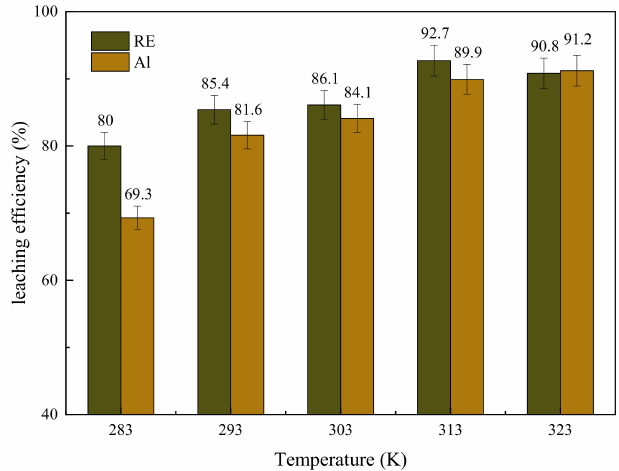
Figure 11. Leaching e ffi ciencies of rare earth and aluminum at di ff erent temperatures.